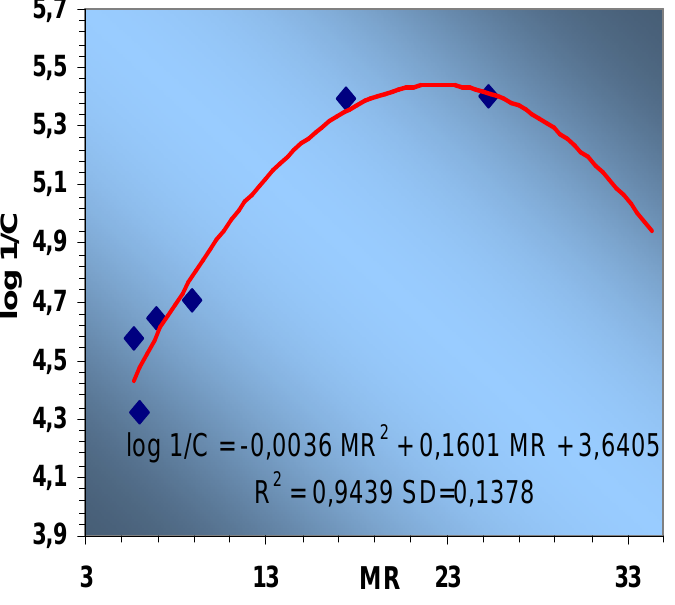
Figure 4. Parabolic correlation between log 1/C and